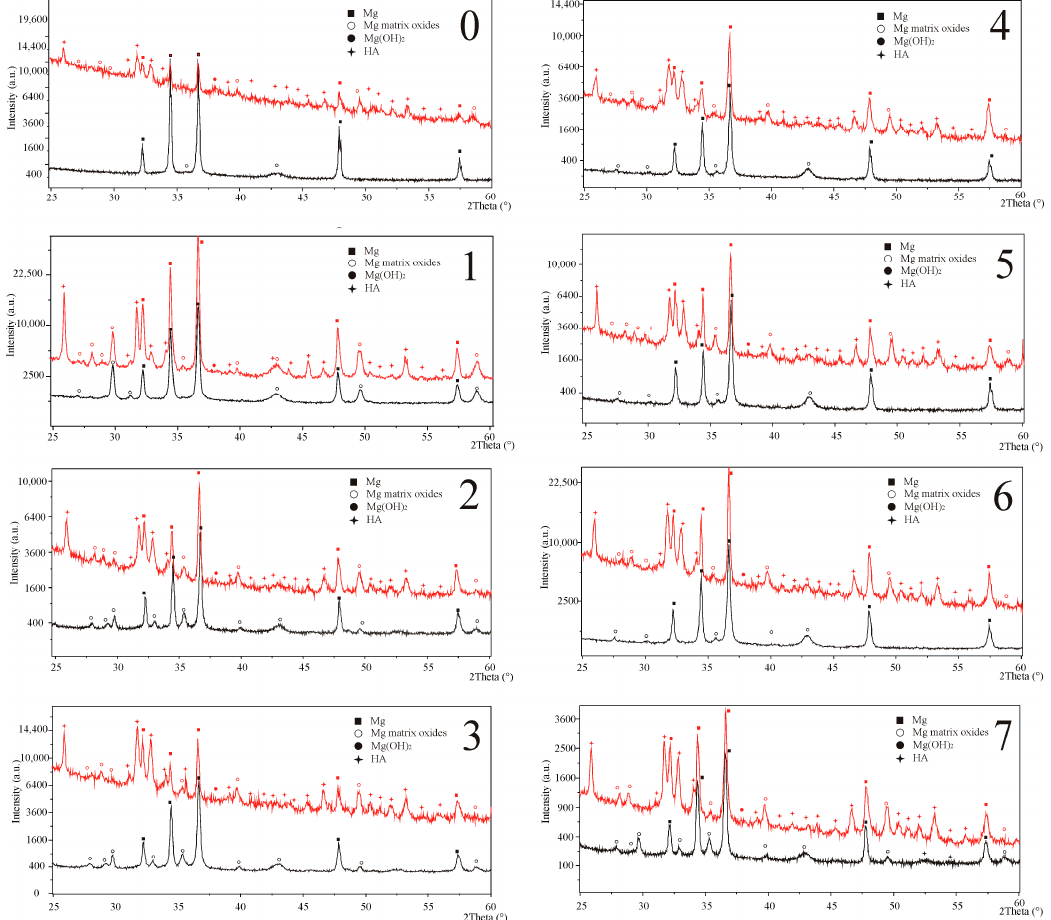
Figure 2. XRD spectra of the base (black) and hydrothermally treated (red) samples with detected phases marked in accordance to sample composition. ( 0 ): Mg pure—Reference sample; ( 1 ): Mg4Y5.5Dy0.5Zr; ( 2 ): Mg4Y5.5Dy0.5Zr + 5%BG; ( 3 ): Mg4Y5.5Dy0.5Zr + 5%BG + 1%Ag; ( 4 ): Mg1Zn1Mn0.3Zr; ( 5 ): Mg1Zn1Mn0.3Zr + 5%HA; ( 6 ): Mg1Zn1Mn0.3Zr + 5%HA + 1%Ag; ( 7 ):